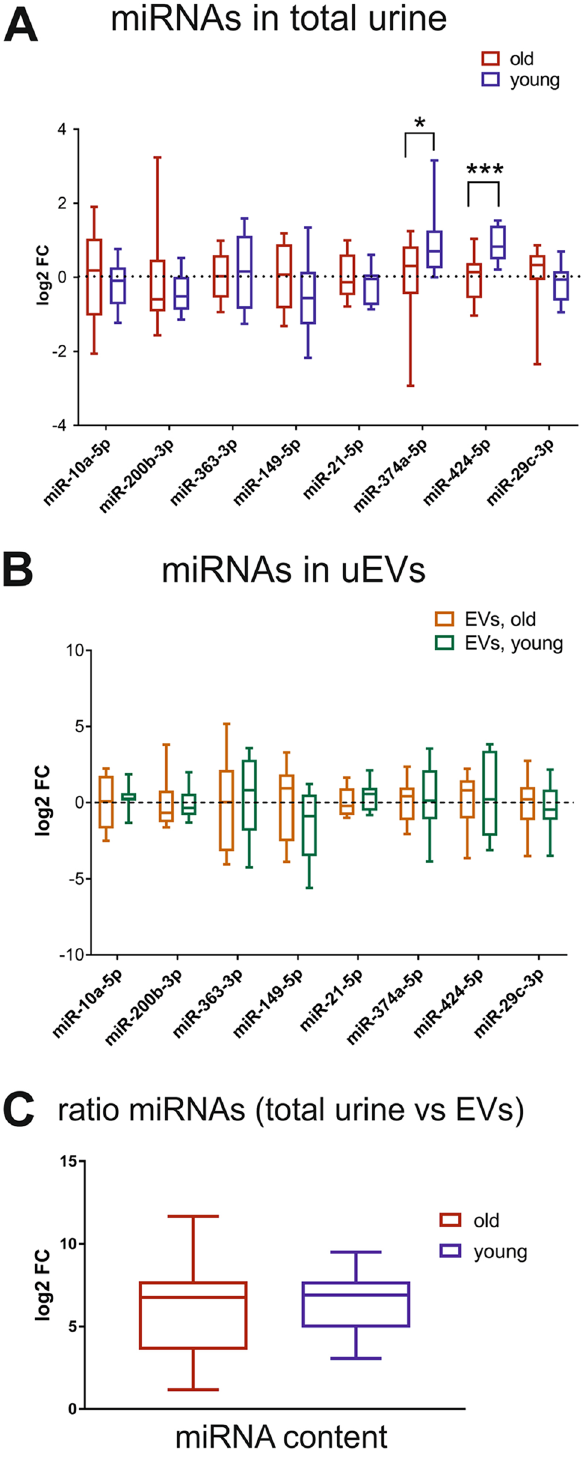
Figure 4. Profiling of abundant miRNA in the total urine and uEVs of healthy age-matched groups. RNA samples were derived directly from 37 ml of total cell-free urine or from uEVs, isolated by UC-SEC from 37 ml of the same urine sample, and miRNAs were profiled using RT-qPCR. (A) RT-qPCR results for 8 abundant miRNAs detected in the total urine of “young” and “old” healthy subjects in the morning and afternoon collection (n = 12 per group). Boxplot of log2 fold change relative to the average normalized Ct values in the “old” group. Statistically significant differences * p < 0.05, *** p < 0.001, multiple t-tests). (B) RT-qPCR results for 8 abundant miRNAs detected in the uEVs of “young” and “old” healthy subjects in the morning and afternoon urine (n = 12 per group). Boxplot of log2 fold change relative to “old” group. No significant differences were observed. (C) Log2 fold change between the total miRNA content, proportional to the average Ct values in all samples, and the exosomal miRNA content in the “old” and “young” subjects. No significant differences were